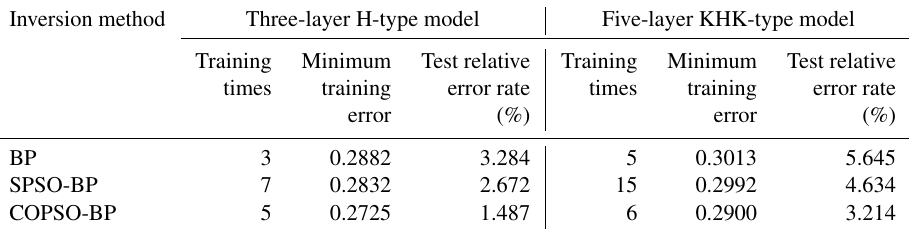
Table 5. Simulation comparison of different algorithms. Inversion